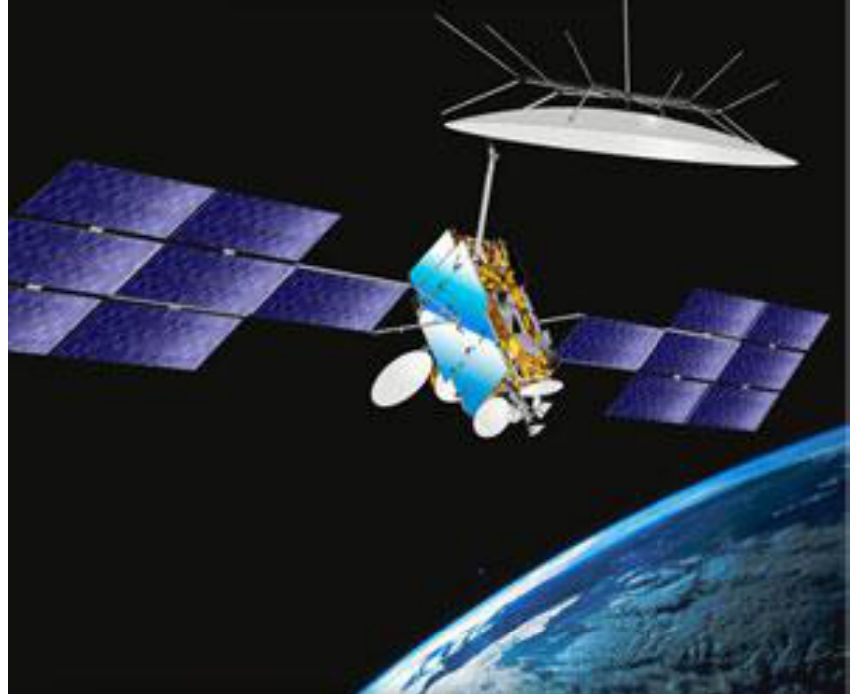
Figure 6. The Eutelsat W2A satellite pictorial image showing the 12 m deployable reflector for the S-band mission.